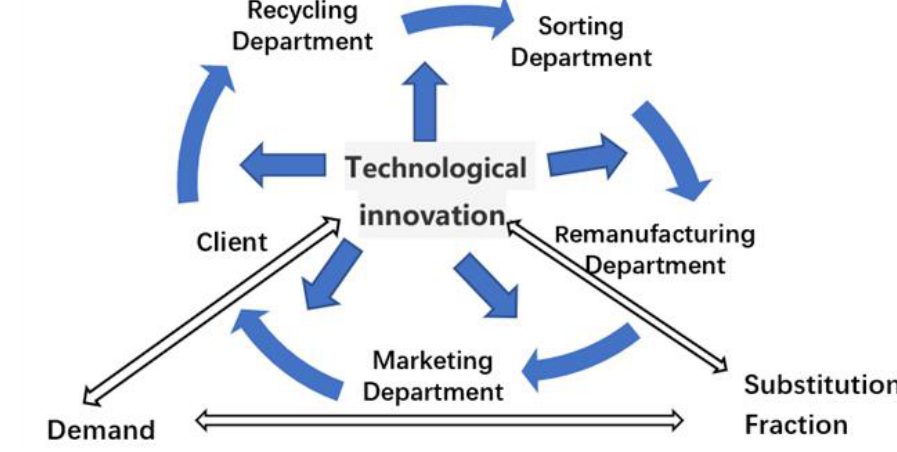
Figure 1. Flow of battery recovery system.